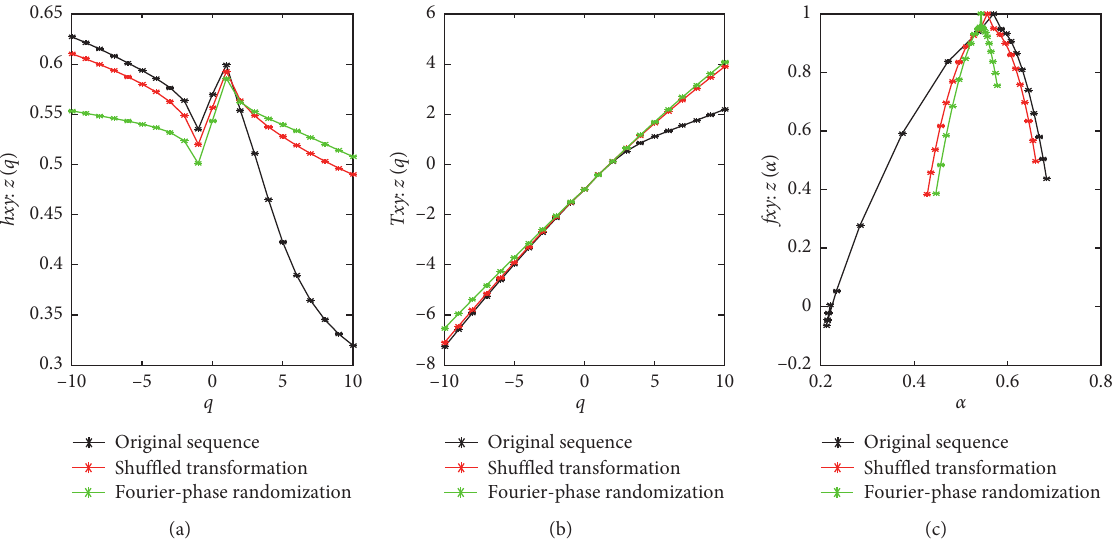
Figure 7: Results of shuffled transformation and Fourier-phase